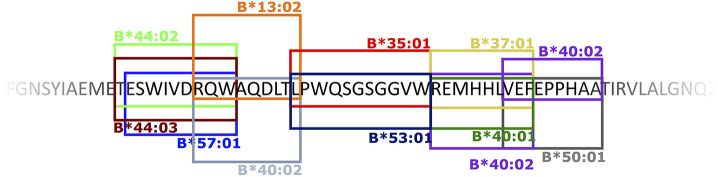
An example of a CD8+ T cell epitope hot spot: the EnvE200−240 region. The 40 amino acid sequence EnvE200−240 included 6 different CD8+ T cell epitopes presented by 10 different HLA-I molecules – in total 12 different peptide-HLA-I combinations. The boxed sequences represent the epitopes that are presented and recognized by the restriction elements indicated at the top or bottom of the box. A box and its indicated restriction element is identically colored.